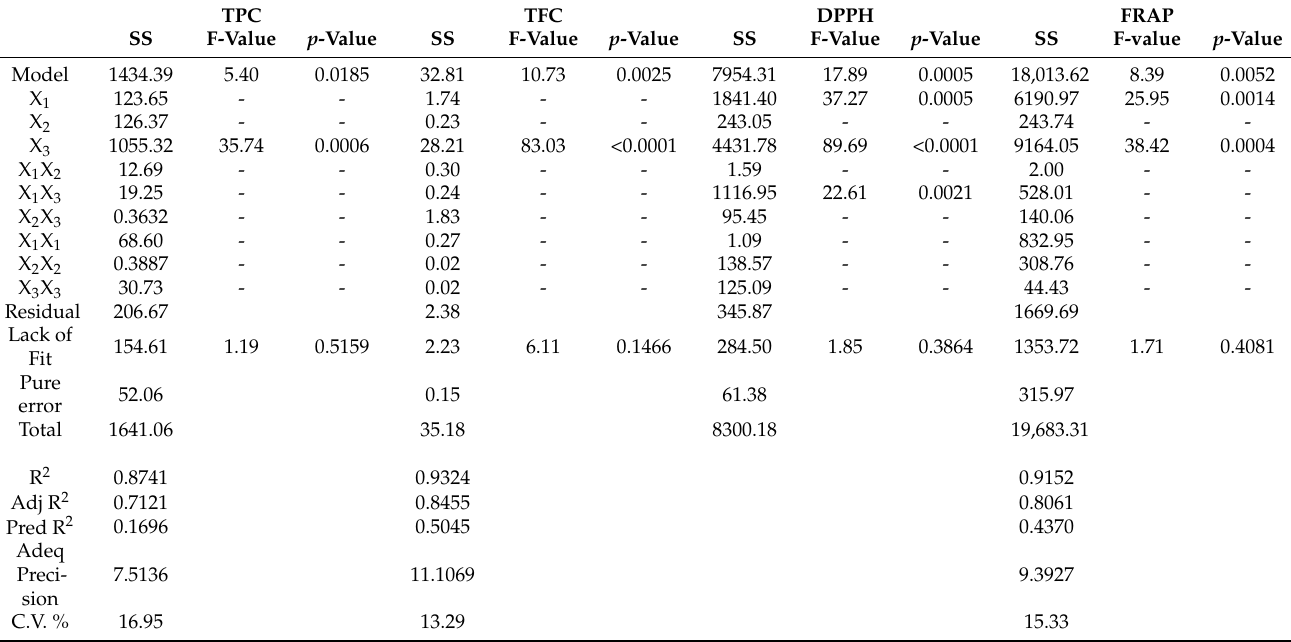
Table 3. Results of ANOVA of the reduced